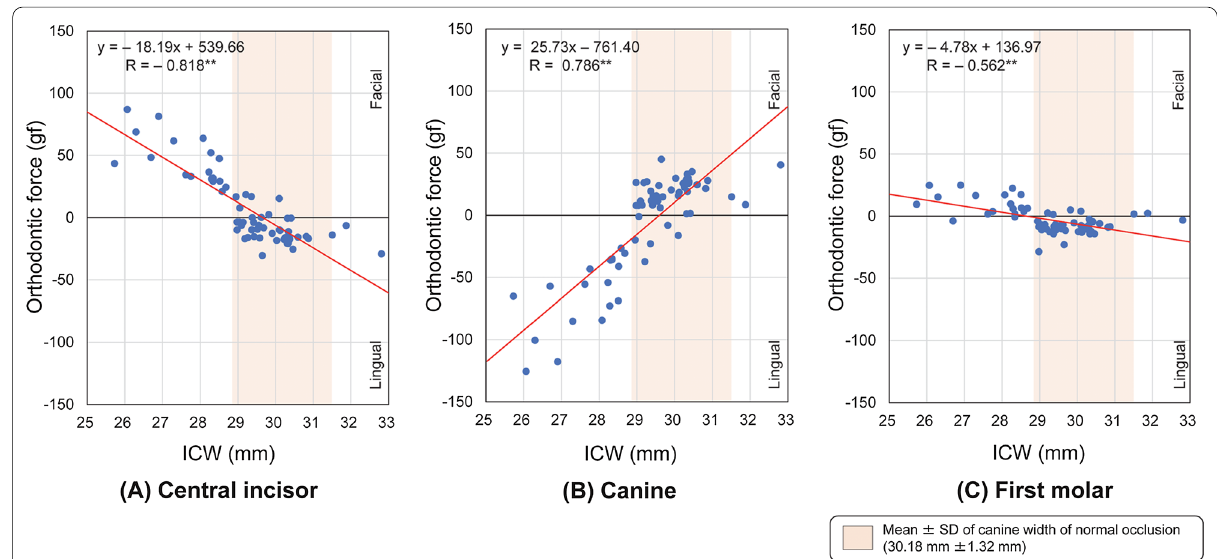
Fig. 4 Spearman correlation coefficients between the intercanine width (ICW) and orthodontic forces delivered by 63 types of preformed archwires to the brackets at the A central incisors, B canines, and C first molars. ** P < .01 (Facial: positive, Lingual: